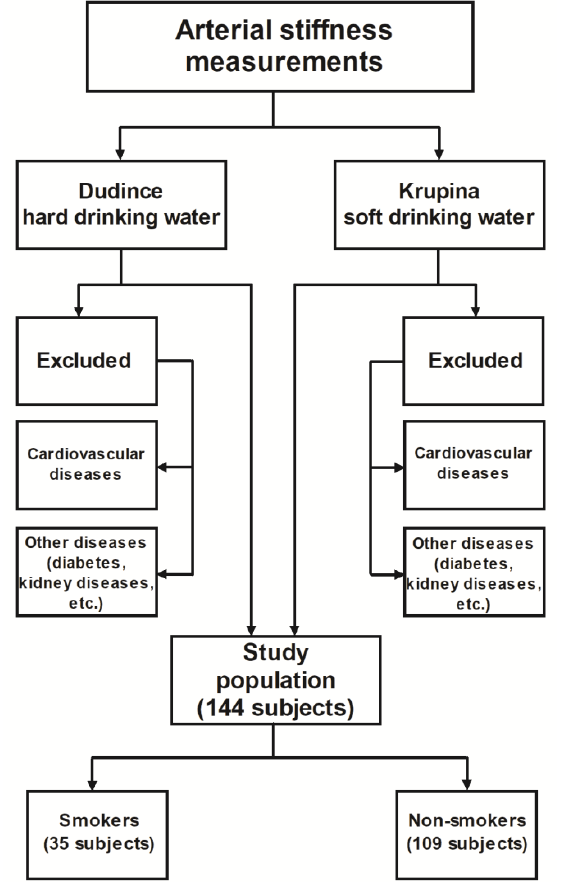
Figure 3. Flowchart showing the selection of respondents included in arterial stiffness measurements.